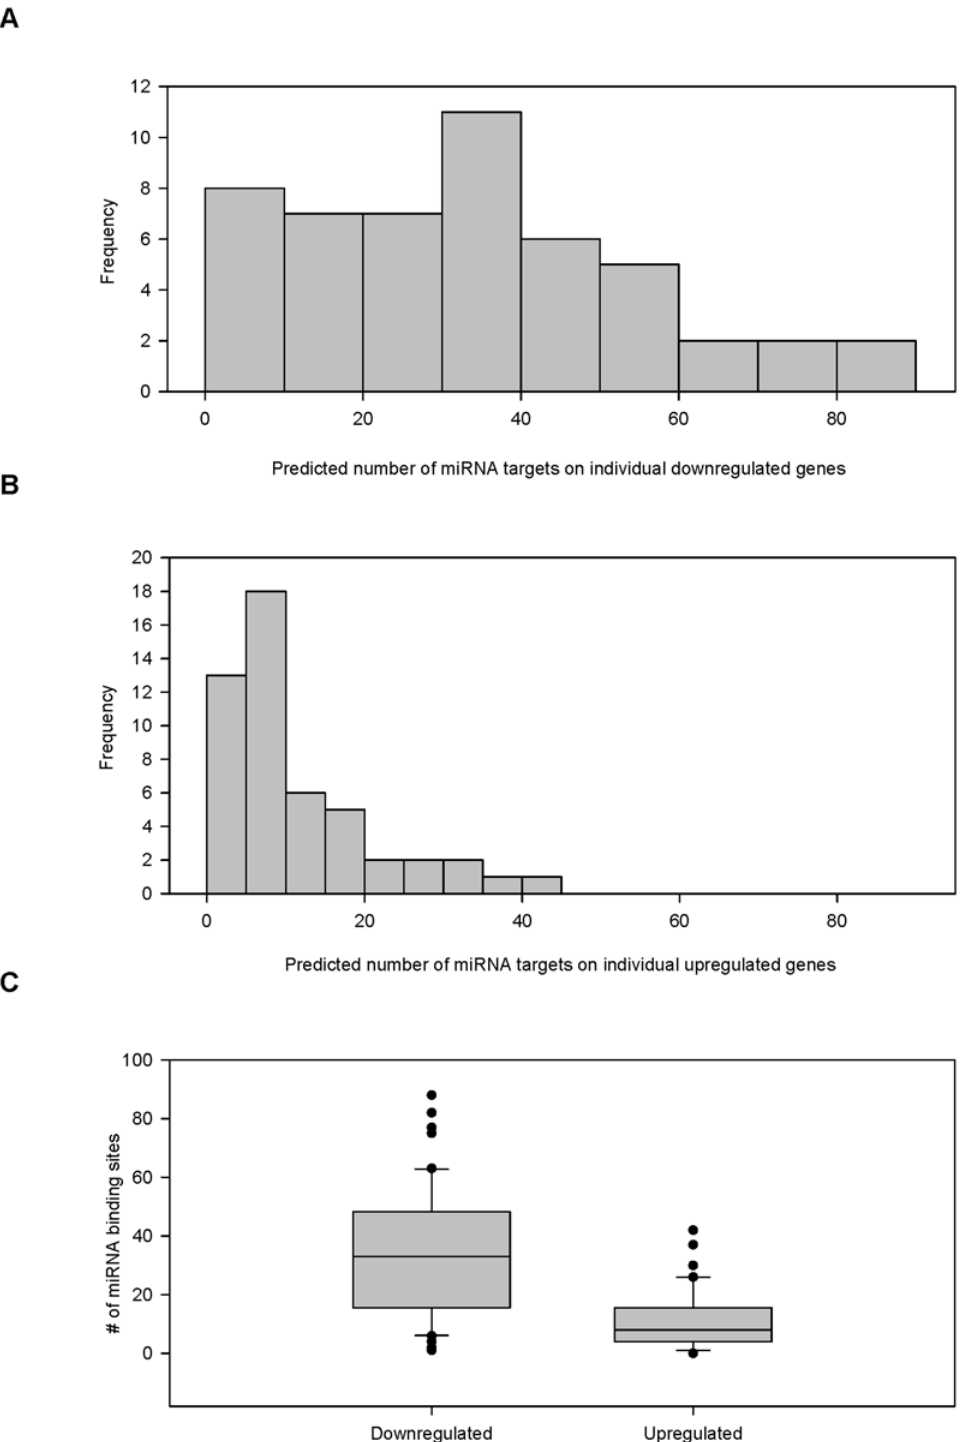
Fig 4. Greater number of miRNA binding sites predicted from probes downregulated on PAA. A random samples of 50 probes upregulated on PAA (FC > 2) was compared to 50 probes highly downregulated on PAA (FC < -10). MicroRNA target sites were predicted from the 3' UTR of each probe for each set collected using the microRNA.org resource. Histograms of the predicted number of miRNA targets are for the probes (A) downregulated on PAA and (B) upregulated on PAA. (C) Box p lot that compared the distribution of the two sets of probes.